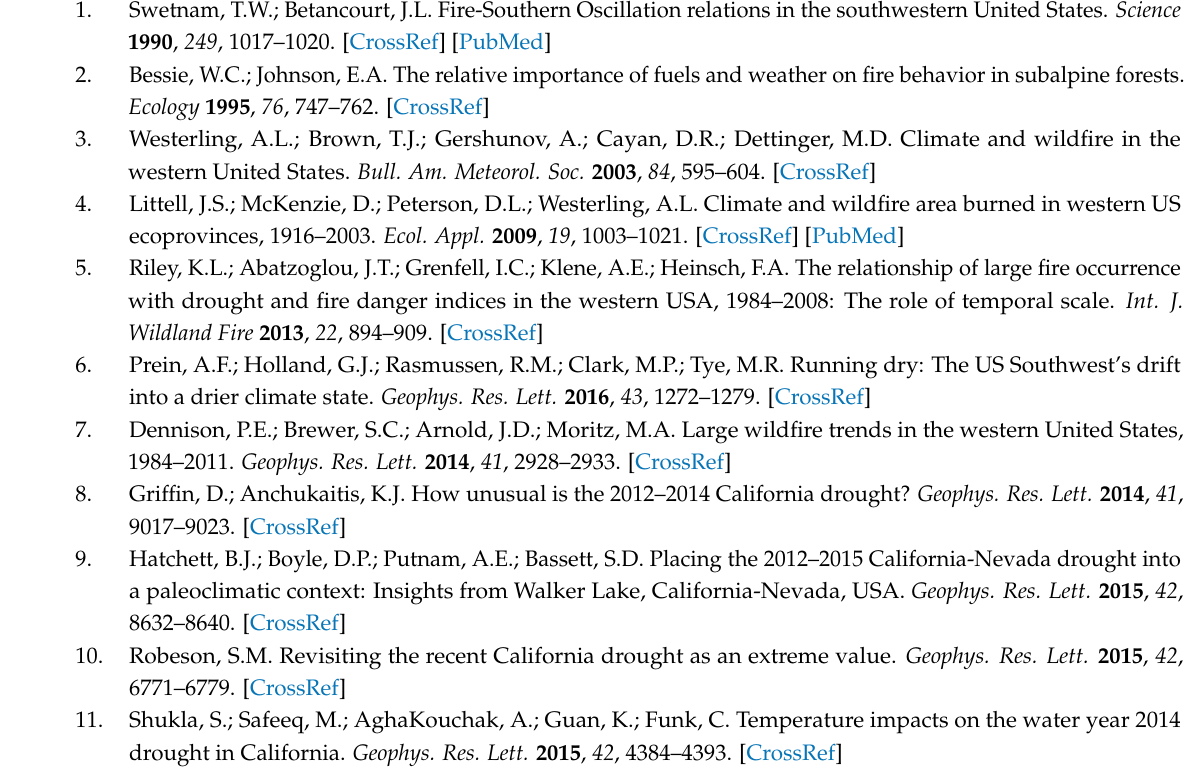
Table S1: California–Nevada domain-average maximum R 2 between seasonally averaged 1000-hr fuel moisture and drought indices, Table S2: California–Nevada domain-average maximum R 2 between seasonally averaged 1000-hr fuel moisture and drought